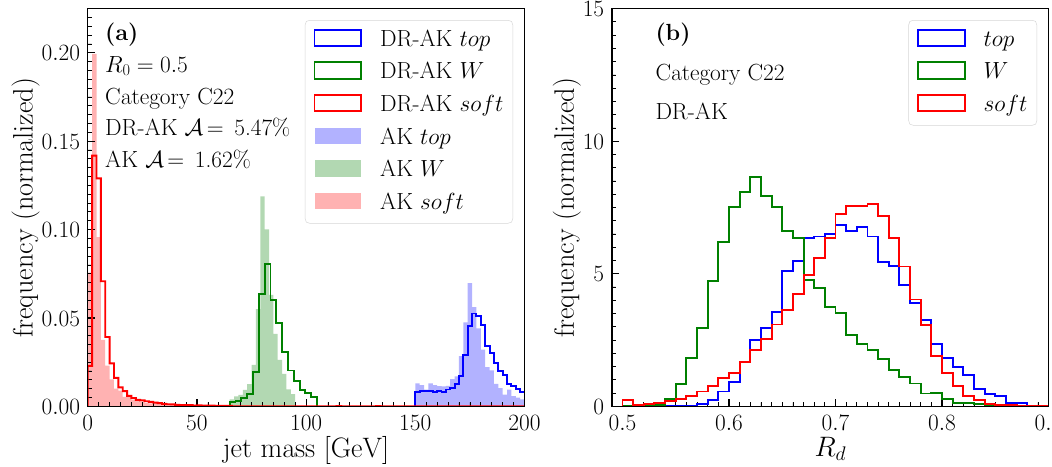
Figure 11 . (a) The normalized distribution of jet mass of the category C22 events for the ¯ pp → b 0 b 0 → tW − ¯ tW + process. The blue, green, and red histograms are reconstructed top , W , and soft jets , respectively. The unfilled histograms are for the jets clustered using the DR-AK algorithm while the filled ones are for the jets using the AK clustering algorithm. (b) The normalized distribution of the final radii of top , W , and soft jets with blue, green, and red colours, respectively. For both panels, R = 0 . 5 was used and any additional jets having p 0 soft jet .